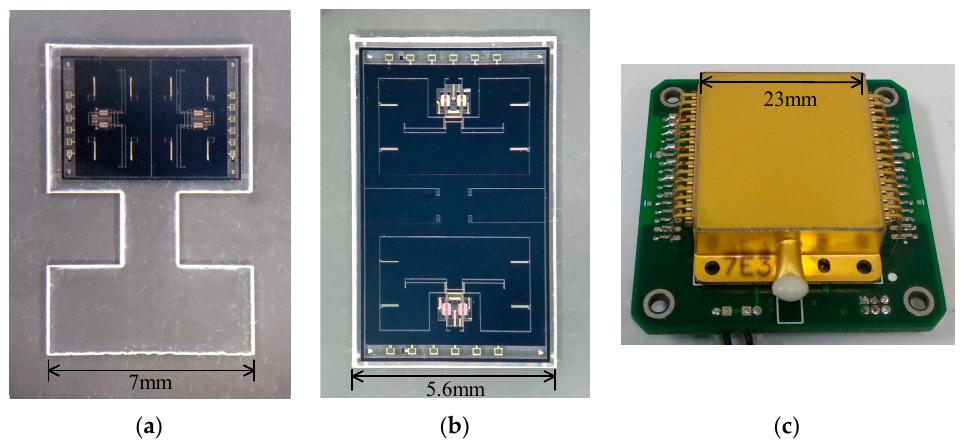
Figure 9. Photographs of the fabricated devices: ( a ) the structure in design A, ( b ) the structure in design B, ( c ) the vacuum packaged MRA device on the interface circuit board.